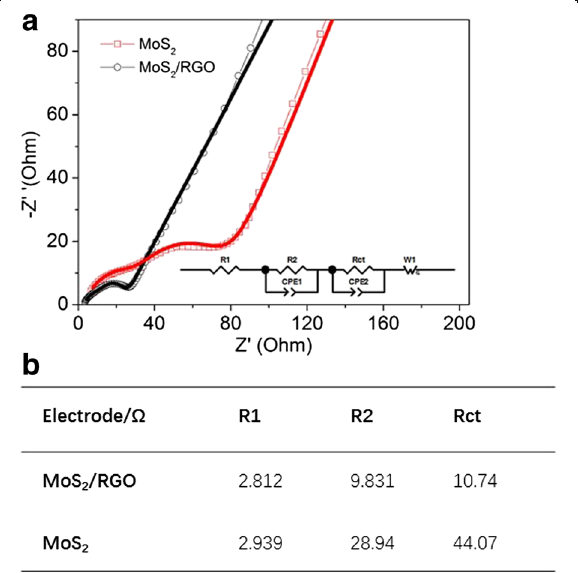
Fig. 5 a Nyquist plots of MoS2/RGO and MoS2 electrodes at fully charged state after 100 cycles at 100 mA g − 1 , and b values of R1, R2, and Rct obtained by fitting data according to the equivalent circuit model presented in